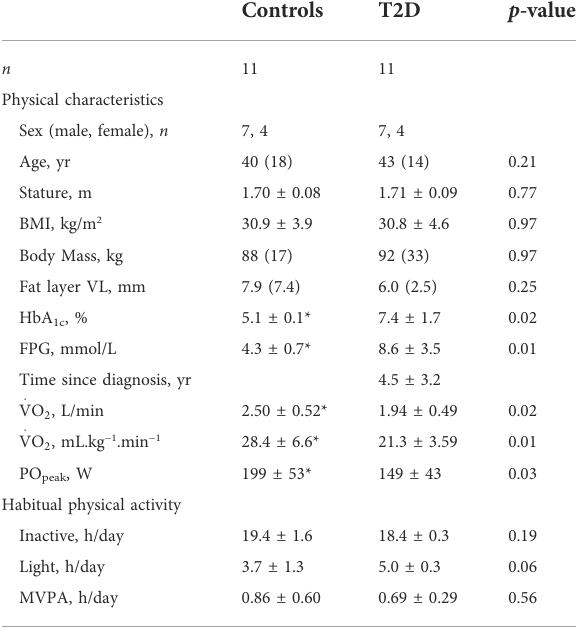
TABLE 1 Physical characteristics, peak exercise values, and activity levels. Controls